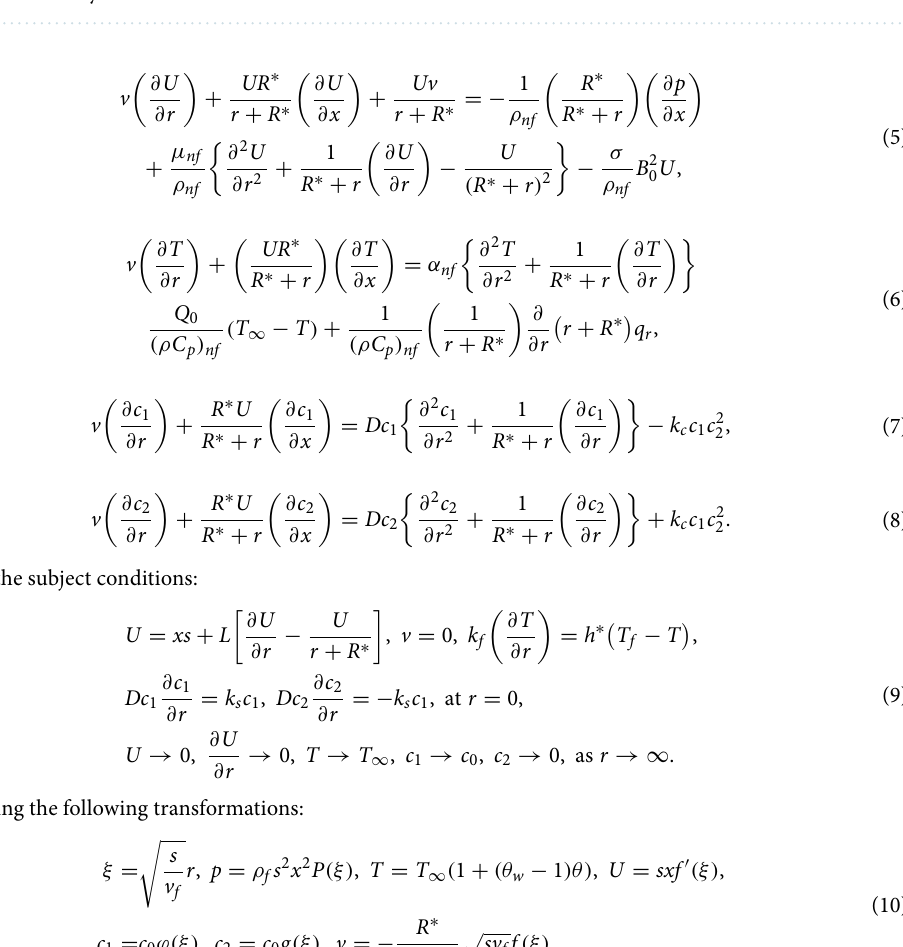
Figure 1. Geometry of the envisioned nanofluid